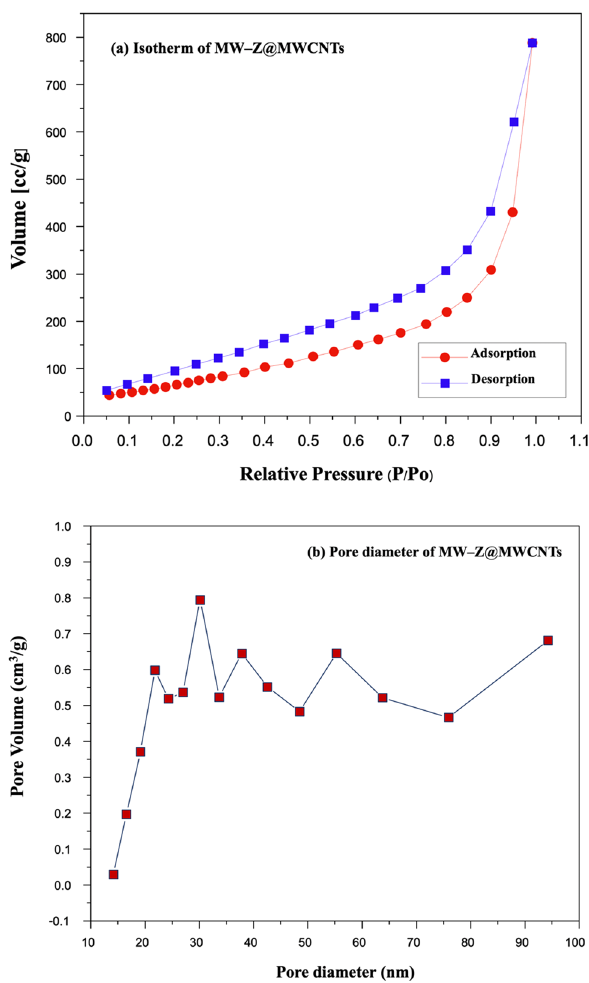
Figure 8. ( a ) Typical N 2 adsorption–desorption isotherm and ( b ) pore size distribution curve of MW-Z@